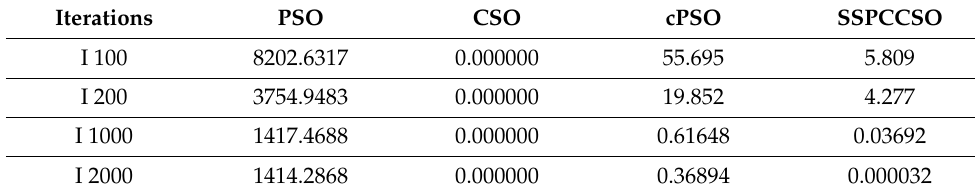
Table 5. The convergence results on test function 1 based on the same iterations.